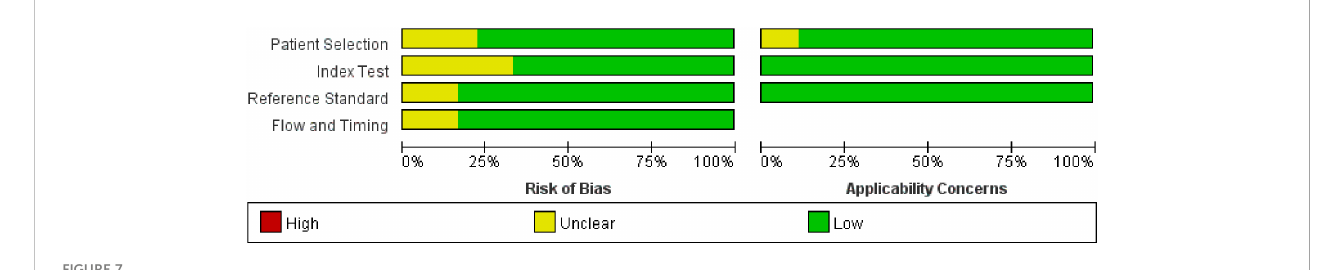
FIGURE 7 Literature quality evaluation of group